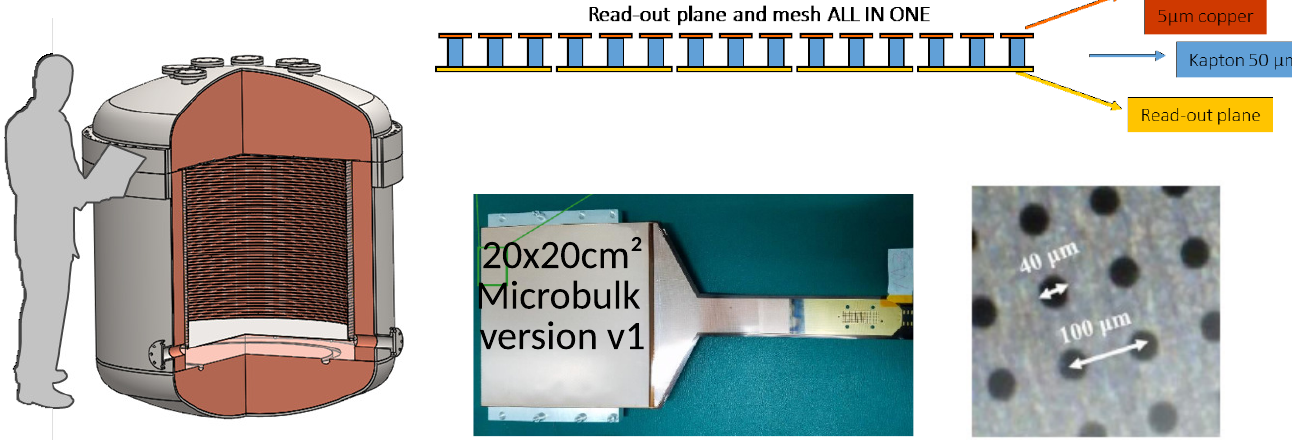
Figure 20. The first TPC of the PandaX-III experiment ( left ). Principle of a Microbulk detector ( top ). Picture of a PandaX-III Microbulk module ( bottom ) and zoom of the surface ( bottom right